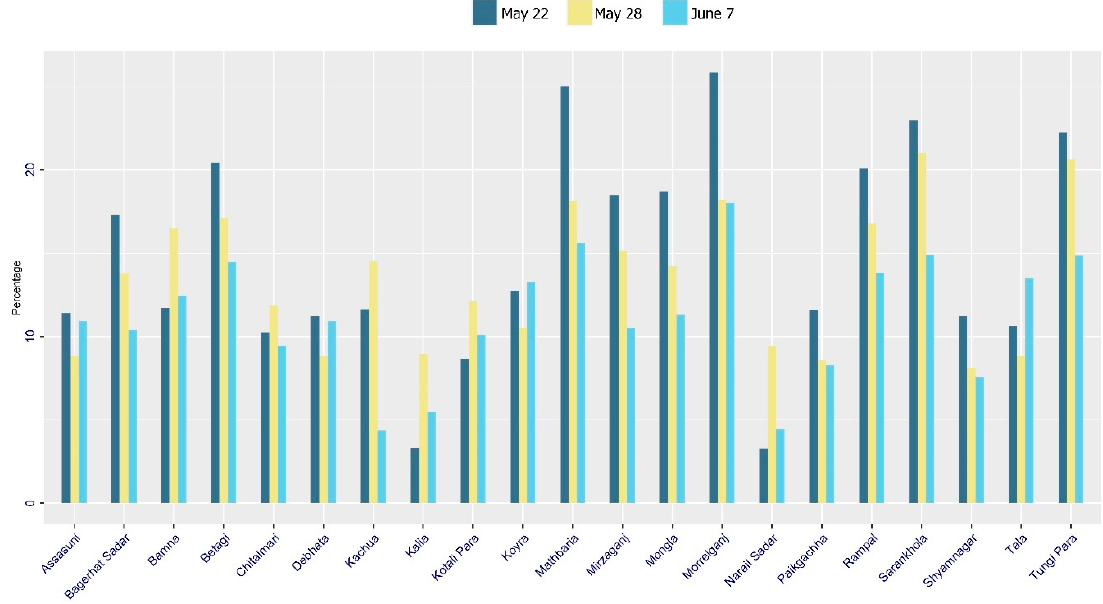
Figure 5. Selected sub-district with changing inundation rate between 22 May and 7 June.